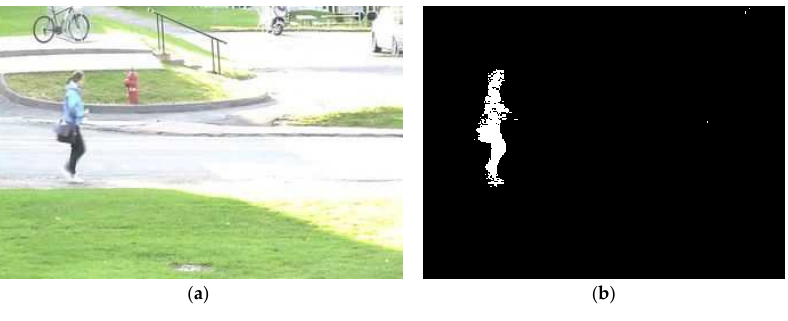
Figure 5. ( a ) Input image, ( b ) foreground.